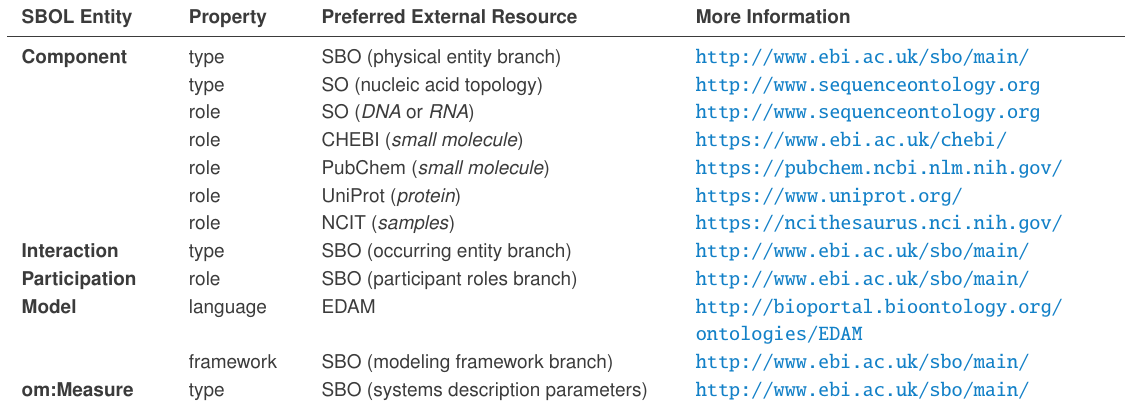
Table 17: Preferred external resources from which to draw values for various SBOL